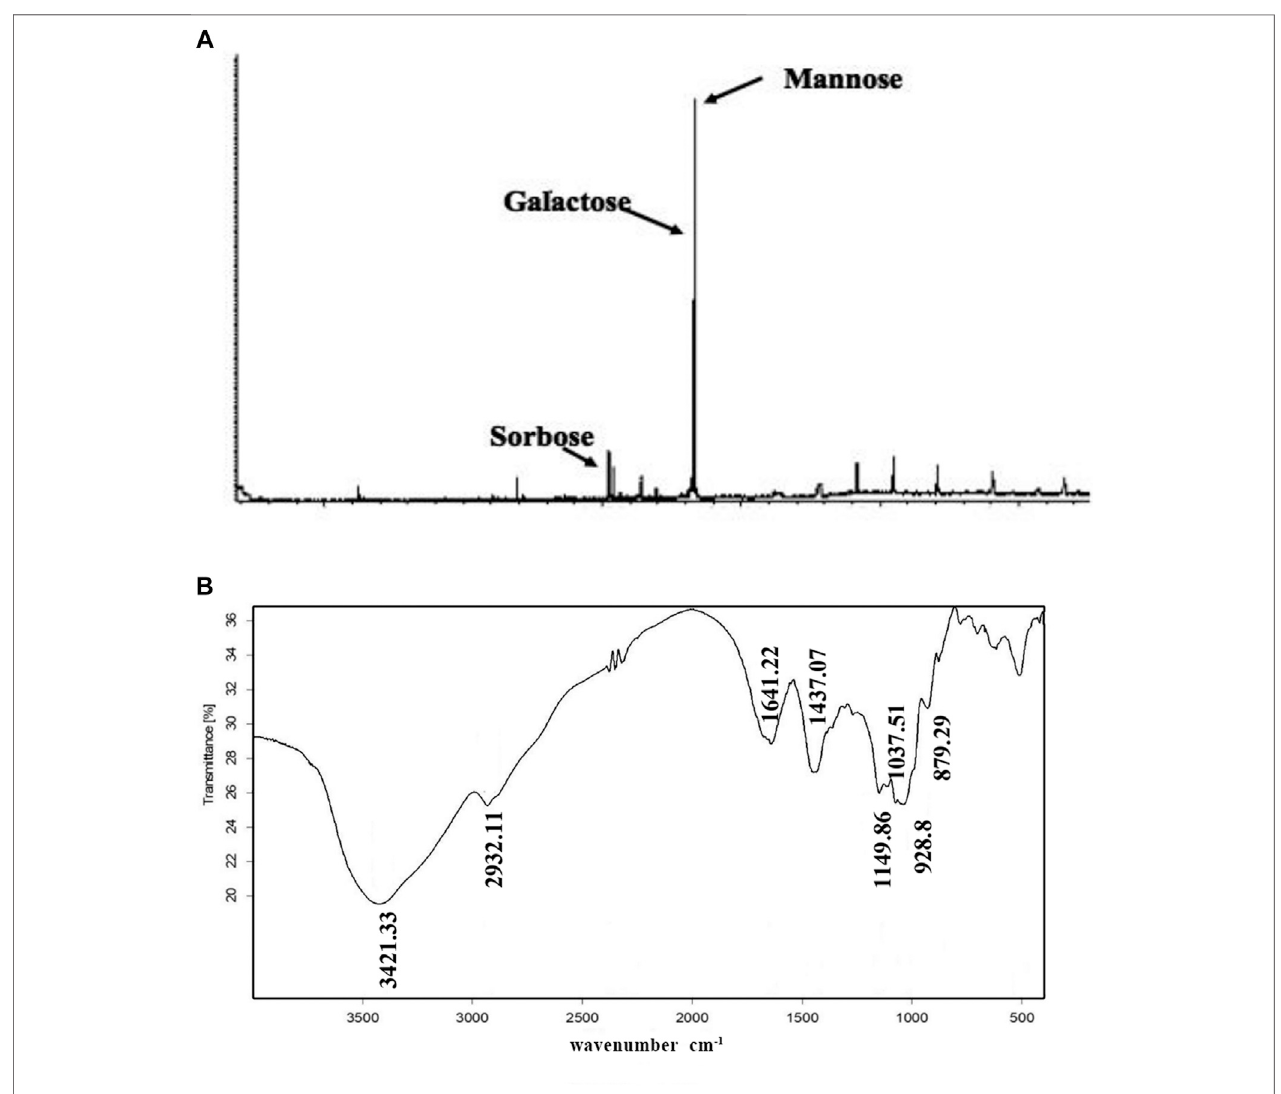
FIGURE2| PNOcompositionandchemicalbondsidenti fi cation. (A) PNOcompositionanalysisconducted via GC-MS. (B) PNOinfraredspectroscopicanalysisresult.